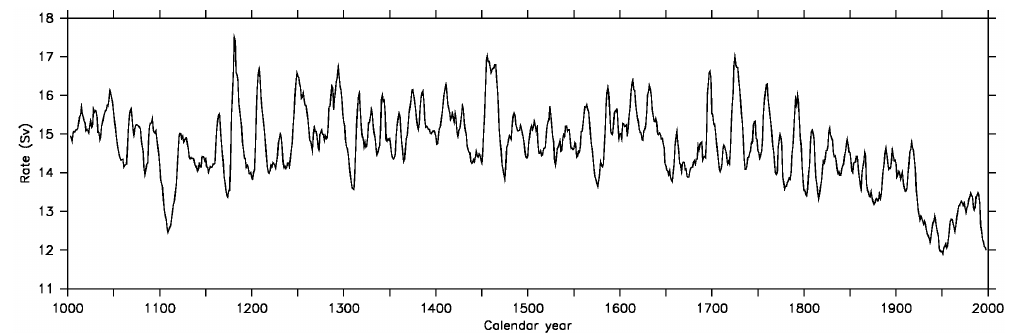
Fig. 17. The change in the rate of North Atlantic Deep Water formation during experiment LAST1000. The values shown are five-year running